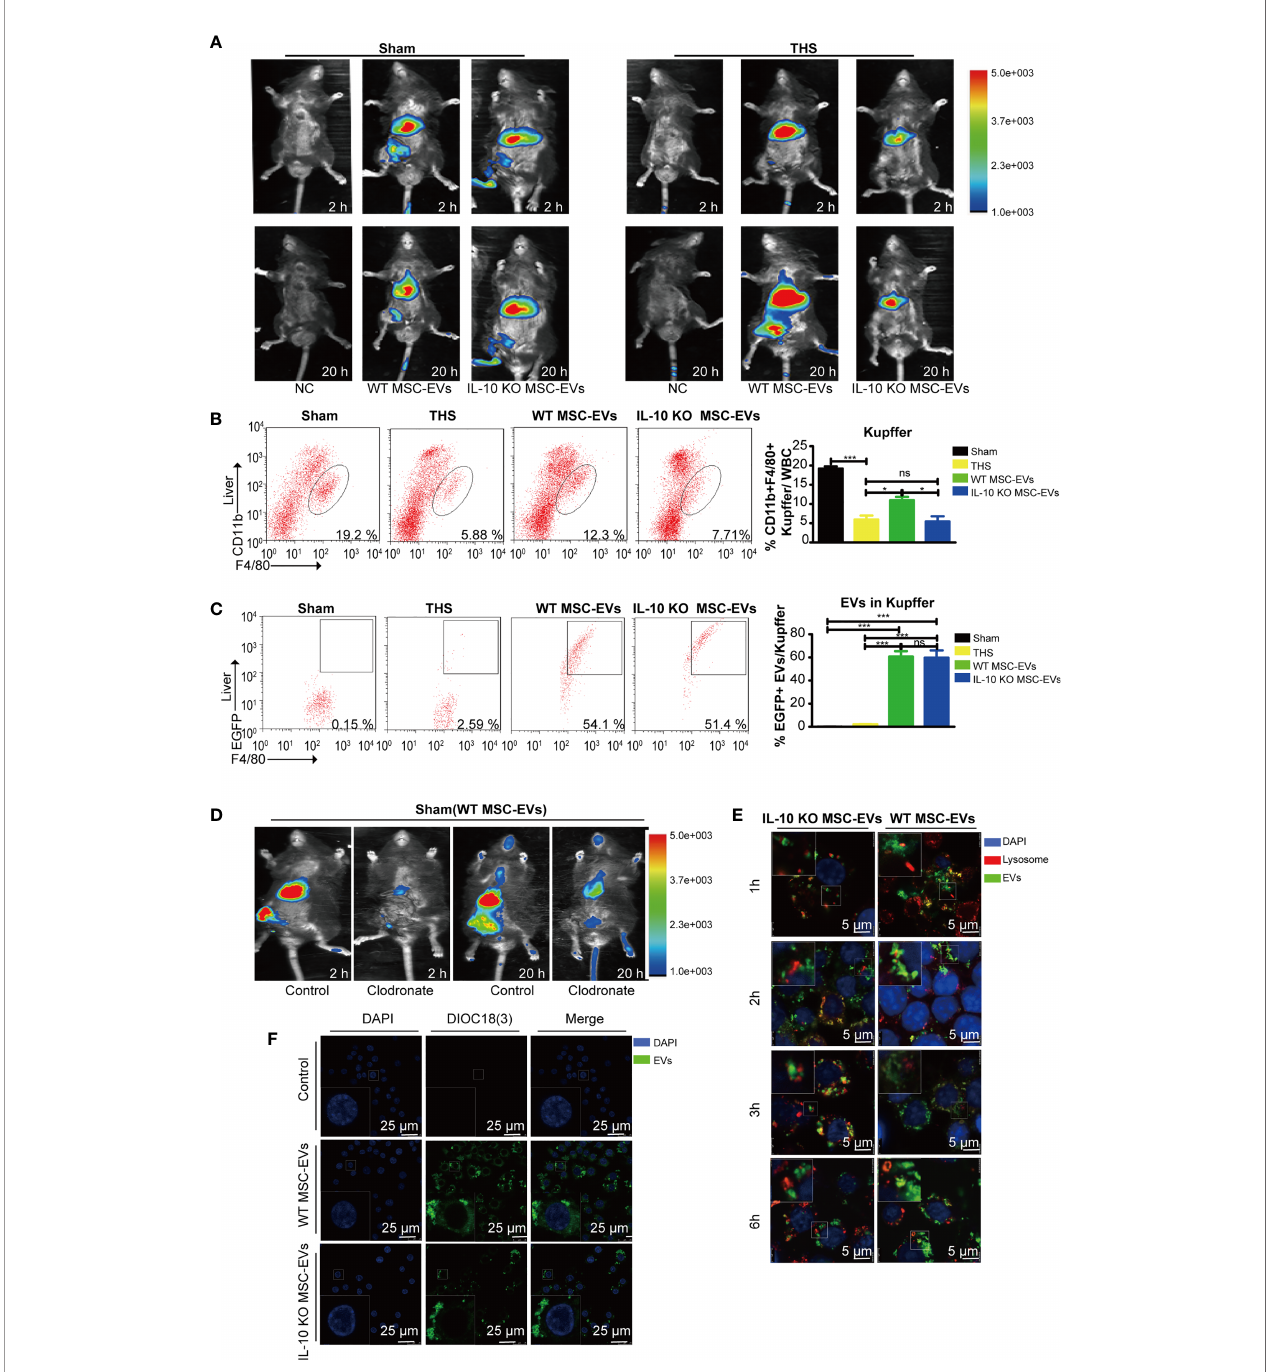
FIGURE 4 | MSC-EVs protect THS-induced hepatic injury by interacting with Kupffer cells. (A) The in vivo distribution of injected EVs labeled with DiR into the sham or THS mice at 2 h and 20 h, respectively. (B, C) Flow cytometry analysis of the number of CD45 + F4/80 + CD11b int Kupffer cells (framed, B) and DIOC 18 (3)-positive cells in the above CD45 + F4/80 + CD11b int Kupffer cells (C) in the indicated groups (n=3 – 5). (D) Clodronate was used to speci fi cally delete macrophages. DiR-labeled EVs were infused into mice and tracked by in vivo imaging at 2 h and 20 h, respectively. (E) Representative confocal images of the subcellular localization of EVs in RAW264.7 cells. Scale bars, 25 m m. (F) Co-localization of EVs with lysosomes in RAW264.7 cells. Scale bars, 5 m m. *P < 0.05, ***P < 0.001; ns, not signi fi cant. All data are shown as the means ±